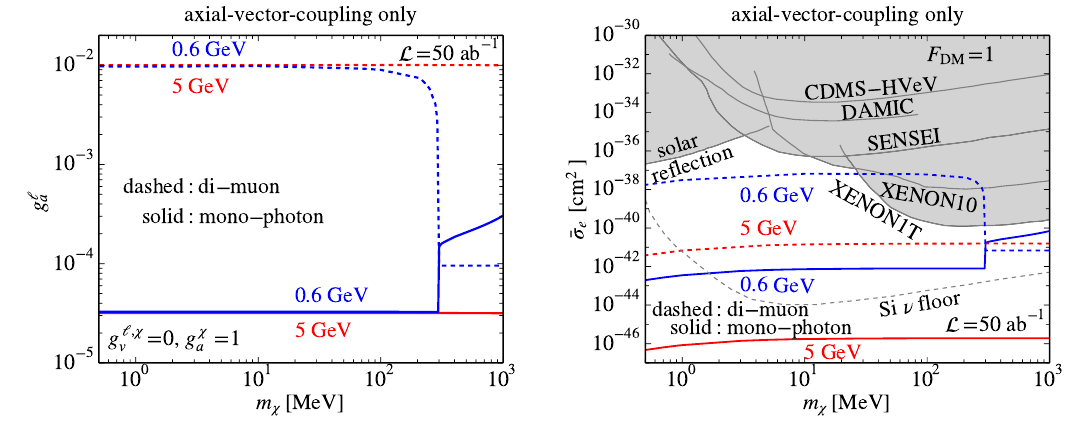
Figure 6 . Same as figure 5 but where only axial-vector coupling are assumed.